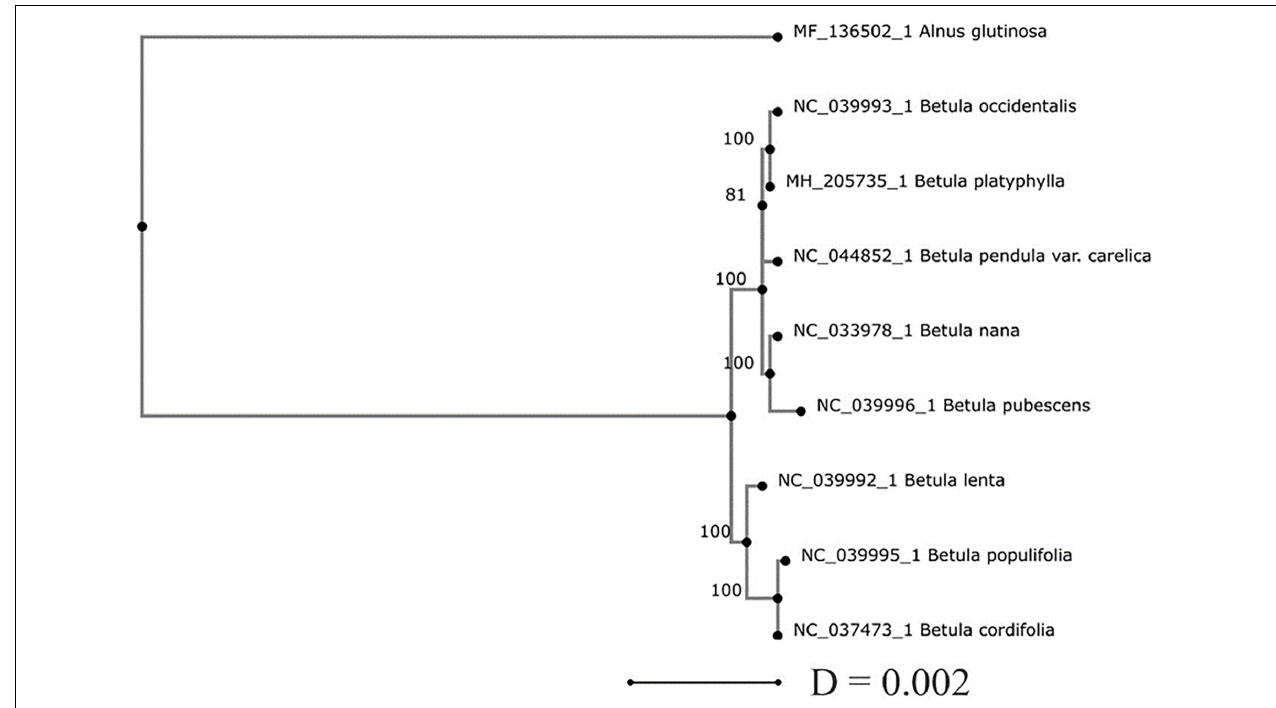
FIGURE 4 | The consensus neighbor-joining (NJ) phylogenetic tree of eight Betula species and the out-group Alnus glutinosa species based on their pairwise Jukes–Cantor (Jukes and Cantor, 1969) genetic distances (D) computed for the whole plastome sequences. The numbers at the cluster nodes are percentages of trees in which the associated taxa clustered together based on 1,000